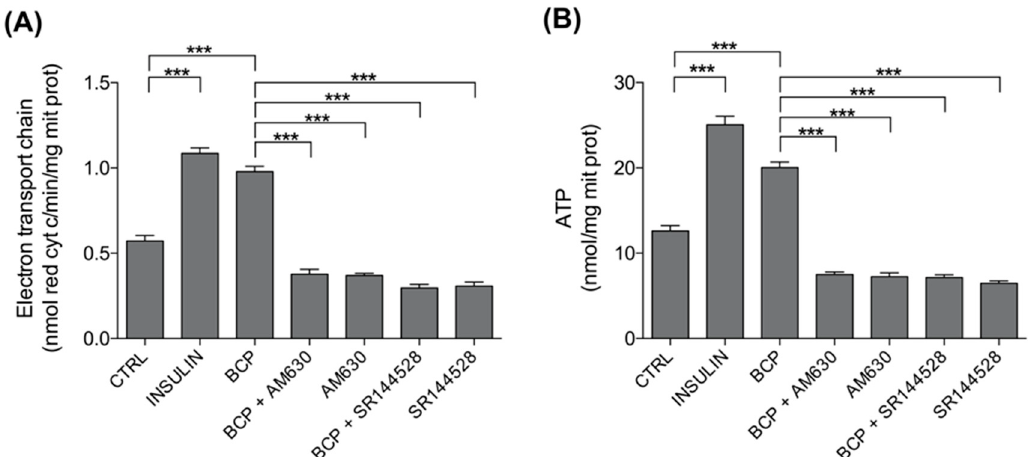
Figure 6. Effects of BCP on mitochondria metabolism. C2C12 cells were left untreated (CTRL) or treated with insulin (25 nM for 30 min; INS), BCP (10 nM for 30 min), AM630 (5 µ M for 2 h) or SR144528 (5 µ M for 2 h), alone or in combination with 10 nM BCP, added in the last 30 min. The electron flux from complex I to complex III ( A ) and the levels of ATP ( B ) were measured spectrophotometrically in mitochondrial extracts in triplicate. Data are expressed as means ± SEM ( n = 3). *** p < 0.001. Table 3. BCP effects on mitochondrial metabolism.